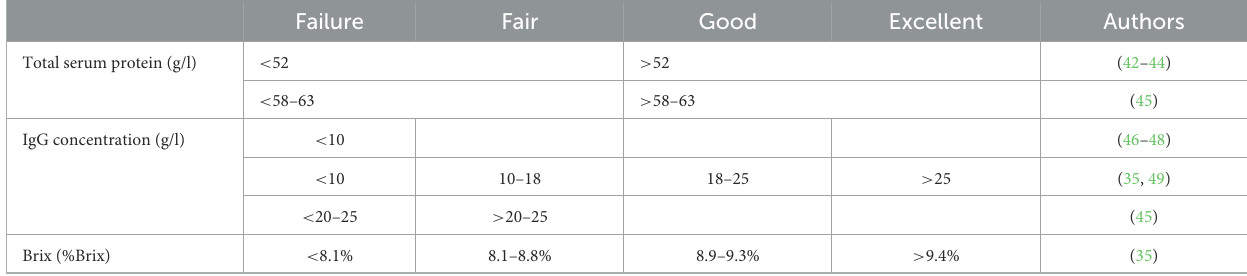
TABLE 2 Cut-off points for passive immunity transfer in calf serum according to total serum protein and IgG concentration from different review studies and the equivalence measured with a Brix